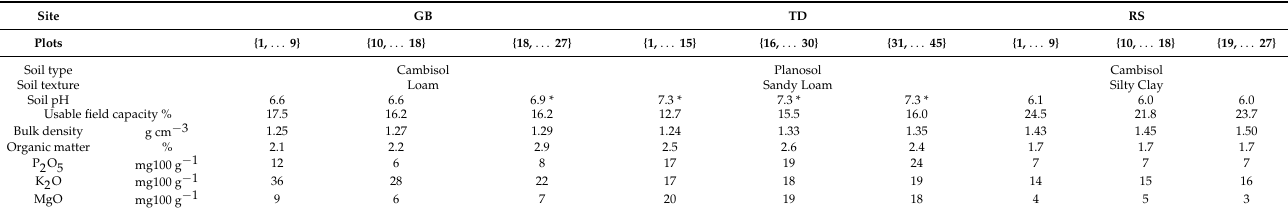
Table 1. Soil properties of three field sites in Bavaria.